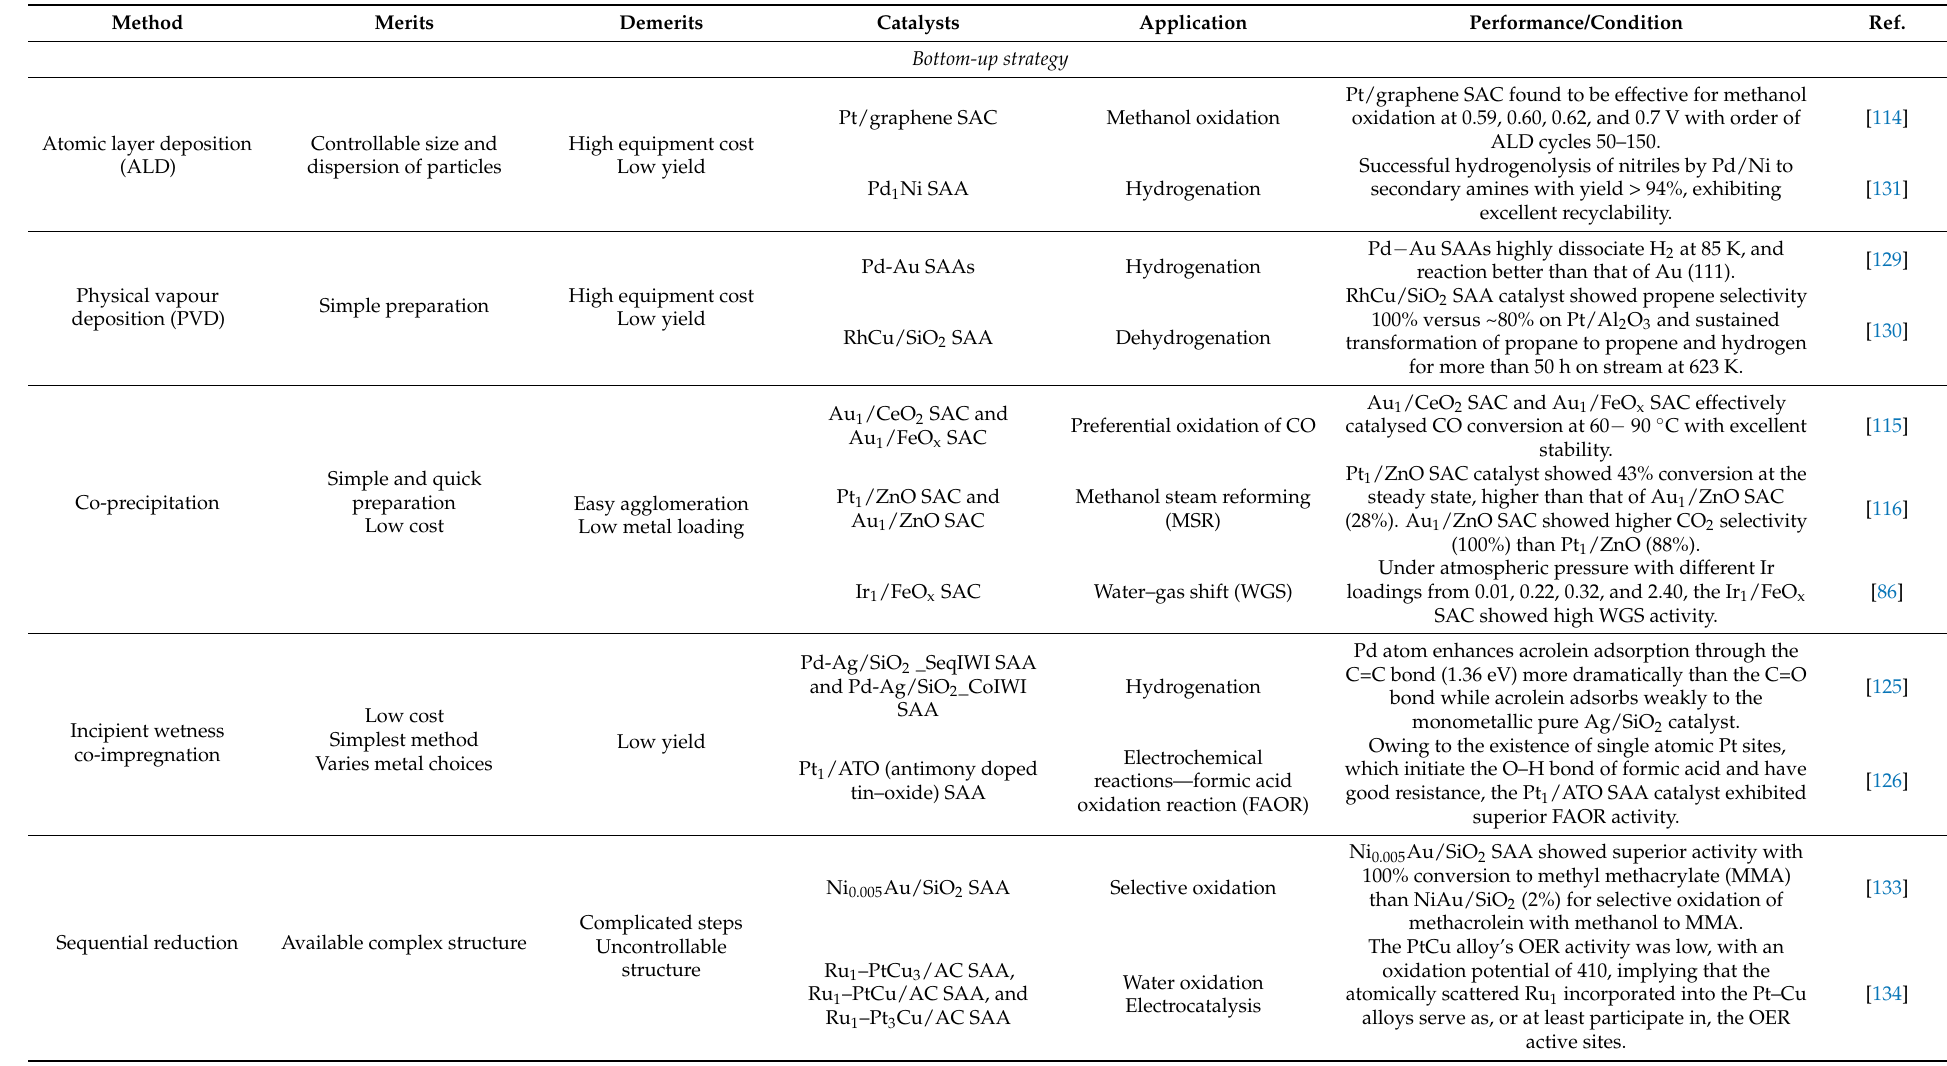
Table 2. Synthetic method of bottom-up and top-down strategies for SACs and SAAs